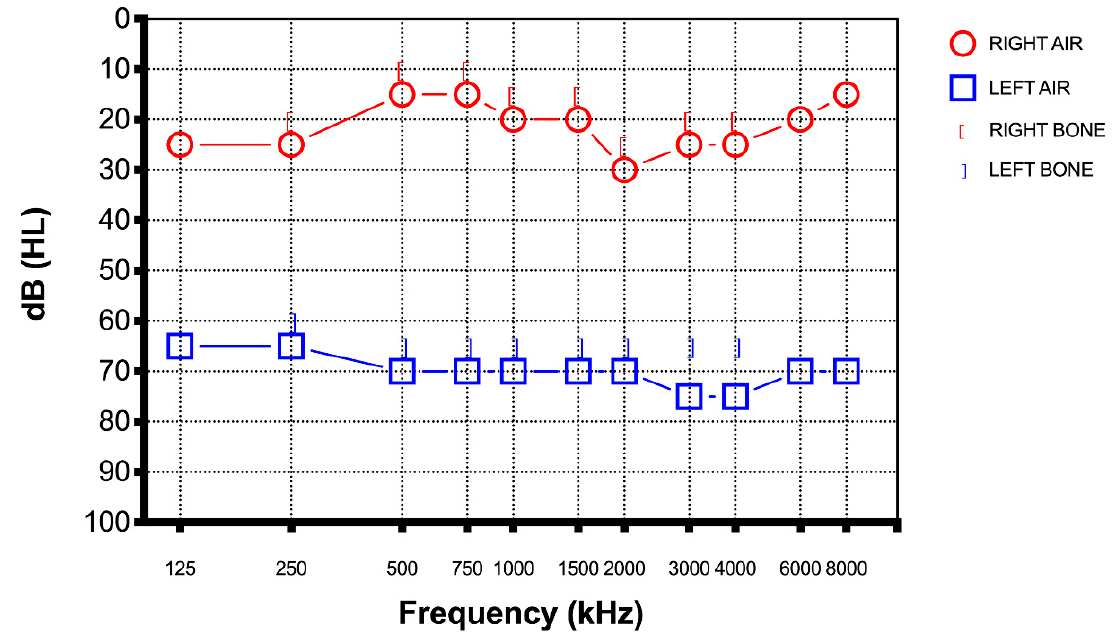
Figure 1. Case 1 pure tone audiometry five days after the third dose of Pfizer-BioNTech COVID-19 vaccine showed profound left SSHL at least 70 dB in every frequency.